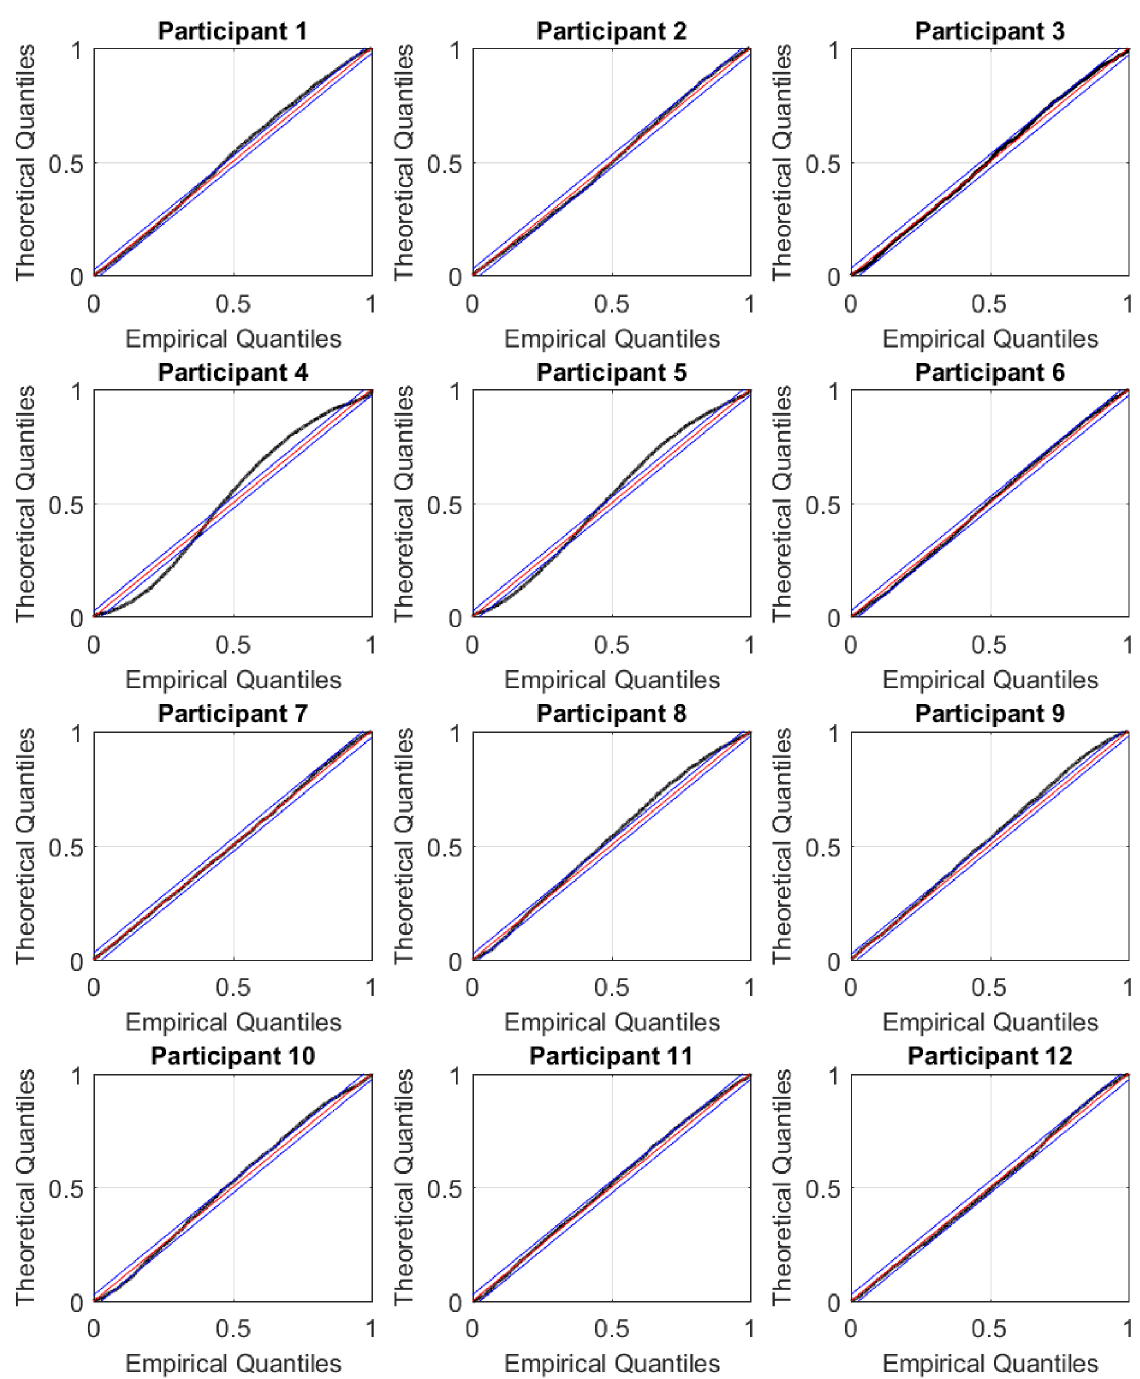
Fig 11. KS plots for the participants. The KS plots for the participants lie close to the 45˚diagonal indicating a good fit to the heartbeats (a point process). Deviations from the 45˚diagonal are most prominent for participants 4 and 5.